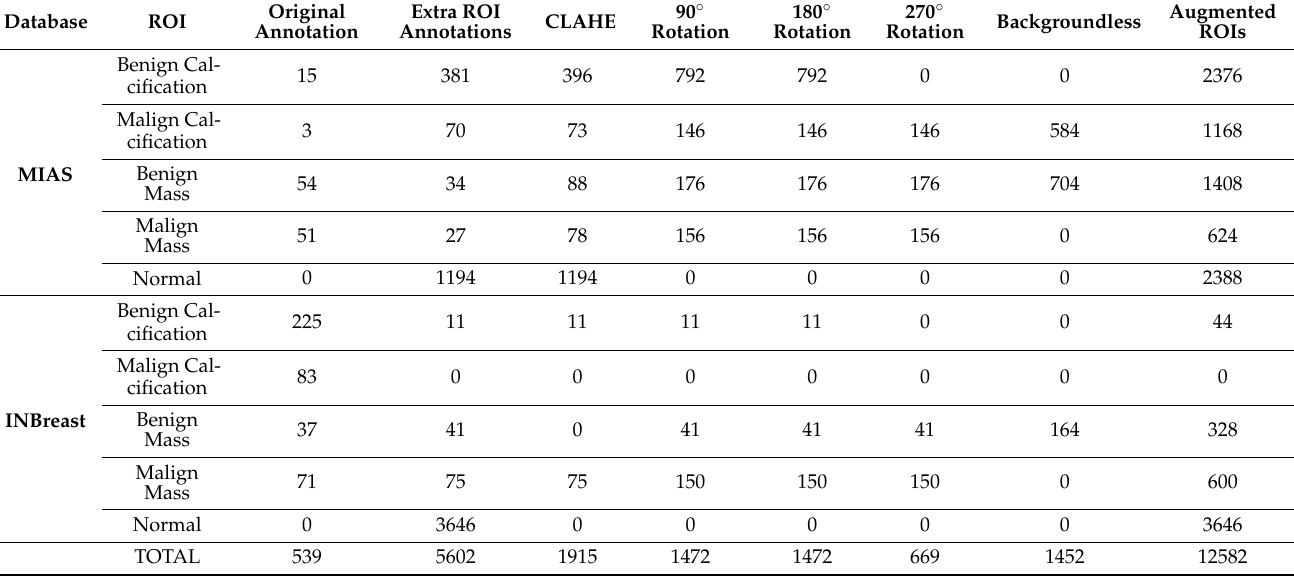
Table 2. Annotated regions and data